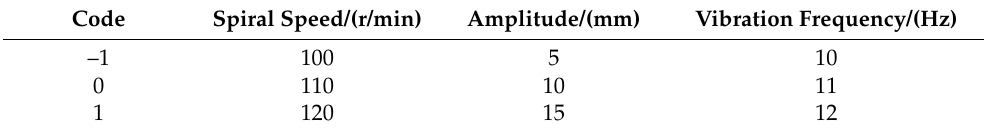
Table 3. Test factor and